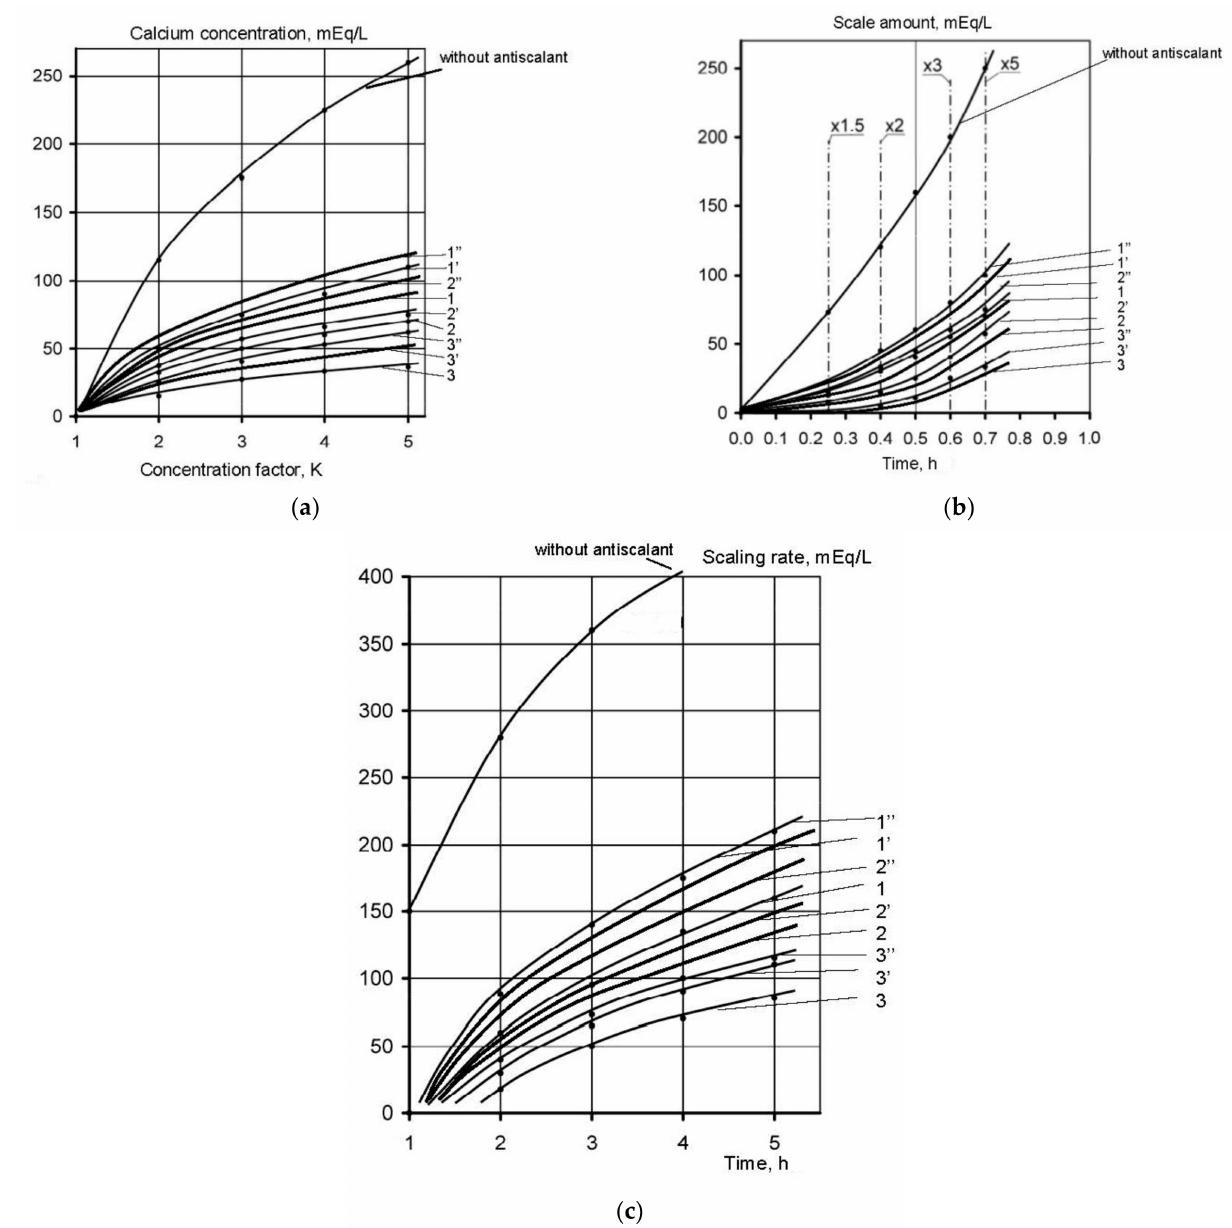
Figure 9. Determination of calcium carbonate growth rates on membranes in the presence of various antiscalants in different doses: ( a ) dependence of accumulated scale amount on K; ( b ) dependence of accumulated scale amount on K; ( c ) dependence of scaling rates on K. 1—Aminat-K, 2 ppm; 1 (cid:48) — Actoscale, 2 ppm; 1 (cid:48) ’—Jurbysoft, 2 ppm; 2—Aminat-K, 5 ppm; 2 (cid:48) —Actoscale, 5 ppm; 2 (cid:48) ’—Jurbysoft, 5 ppm; 3—Aminat-K, 10 ppm; 3 (cid:48) —Actoscale, 10 ppm; 3 (cid:48) ’—Jurbysoft, 10